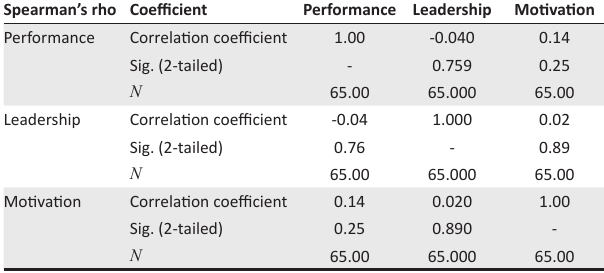
TABLE 6: The overall correlation analysis of the three variables in the study.